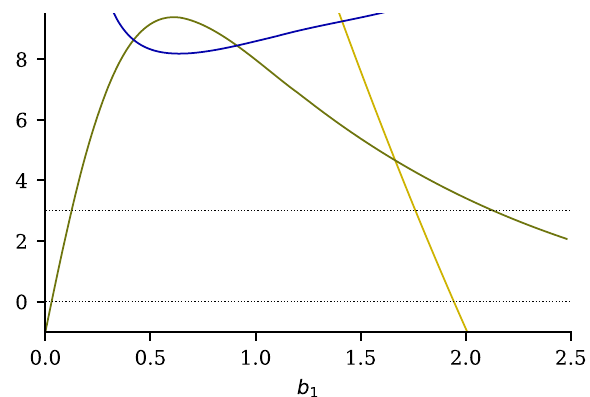
FIG. 9. Figures of merit in dependence of the dipole coefficient b